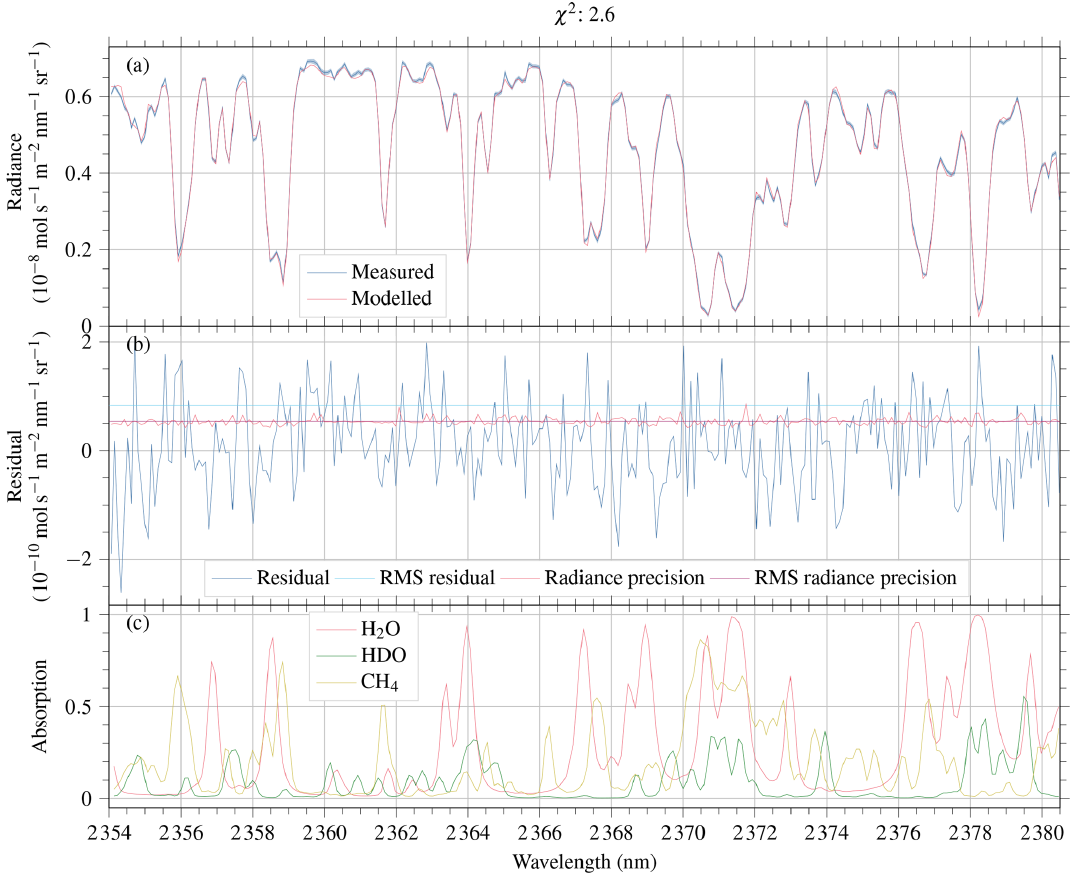
Figure 1. (a) Measured radiance (blue) with its precision (light blue shading) and the spectral fit (red) for ground pixel 149129 in orbit 3969 located near Wollongong, Australia on 20 July 2018. (b) Corresponding residuals (defined as measured minus modelled radiances, in blue) and its root mean square (rms, in cyan), precision of the radiance (in red) and its rms (in purple). (c) Simulated absorption by H 2 O (red), HDO (green) and CH 4